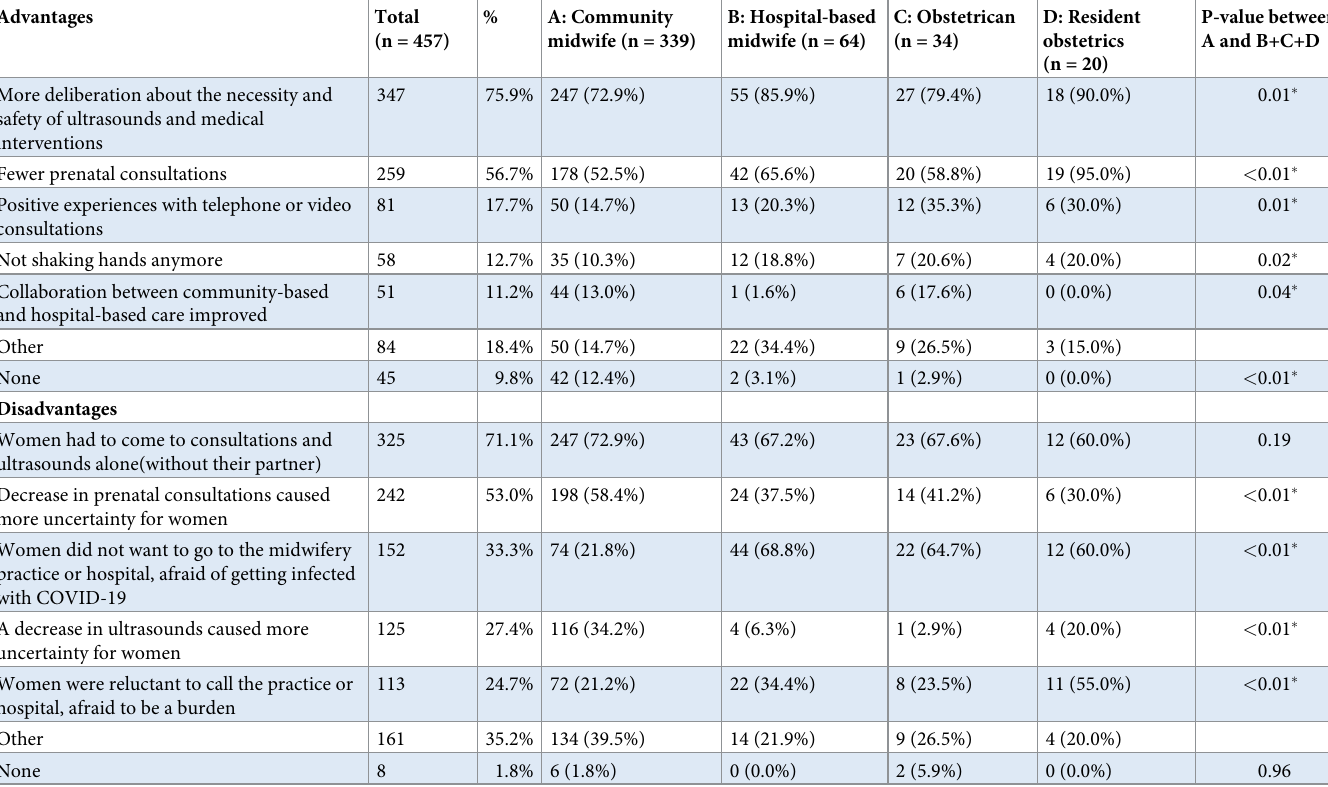
Table 2. Advantages and disadvantages of the changes in prenatal care as experienced by maternity care